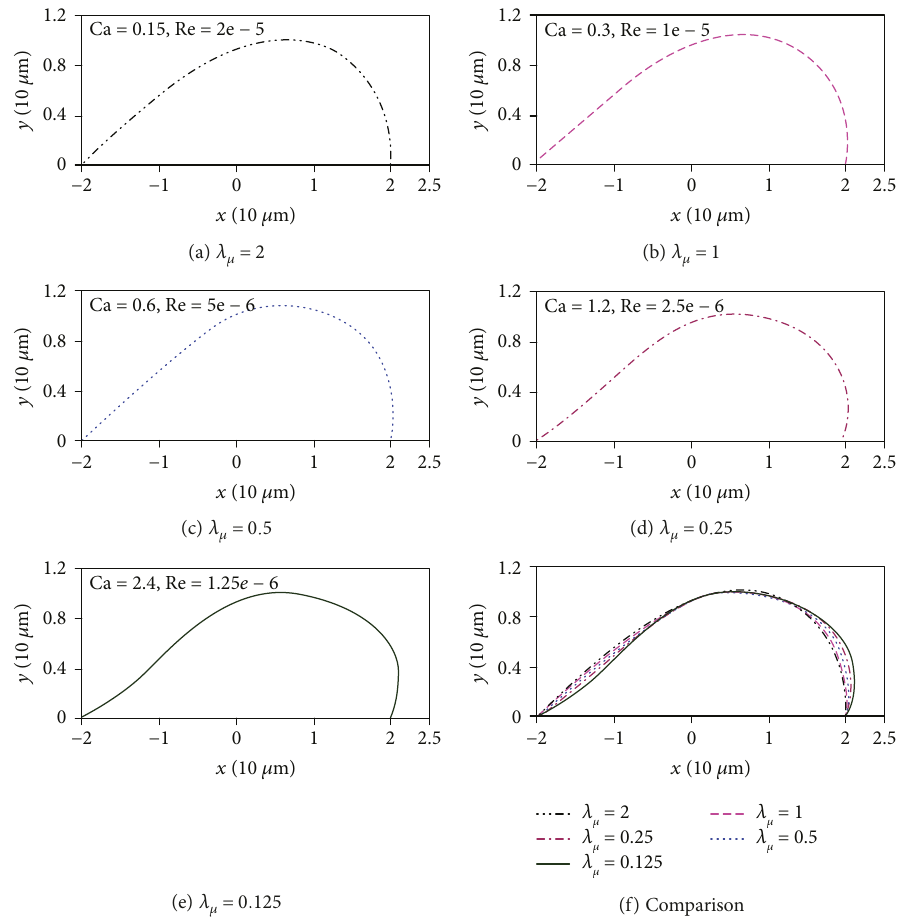
Figure 4: The deformation curve of residual oil with viscosity ratio.